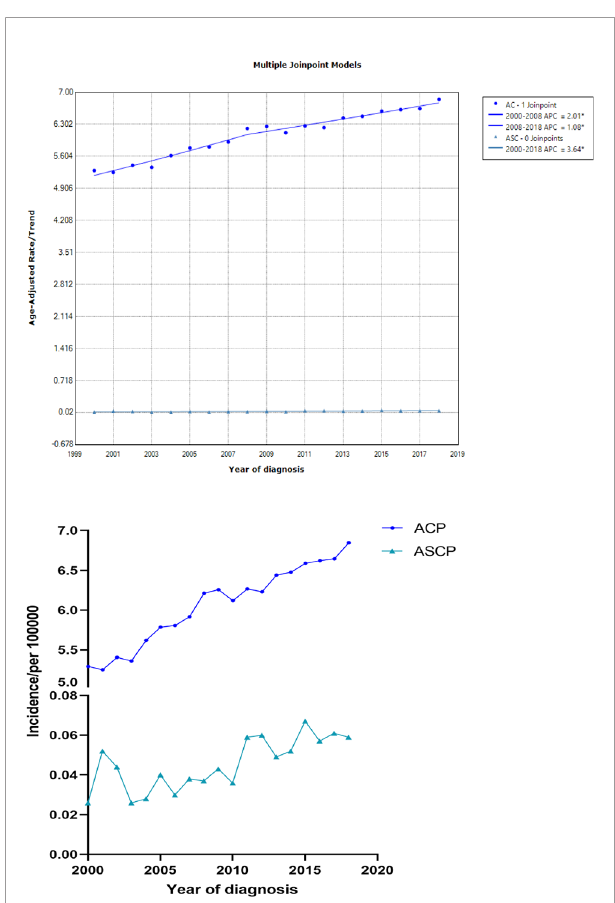
FIGURE 1 | The age-adjusted incidence of ACP and ASCP patients between 2000 and 2018 from the SEER database(ACP, Pancreatic adenocarcinoma; ASCP, Pancreatic adenosquamous carcinoma; APC, annual percent